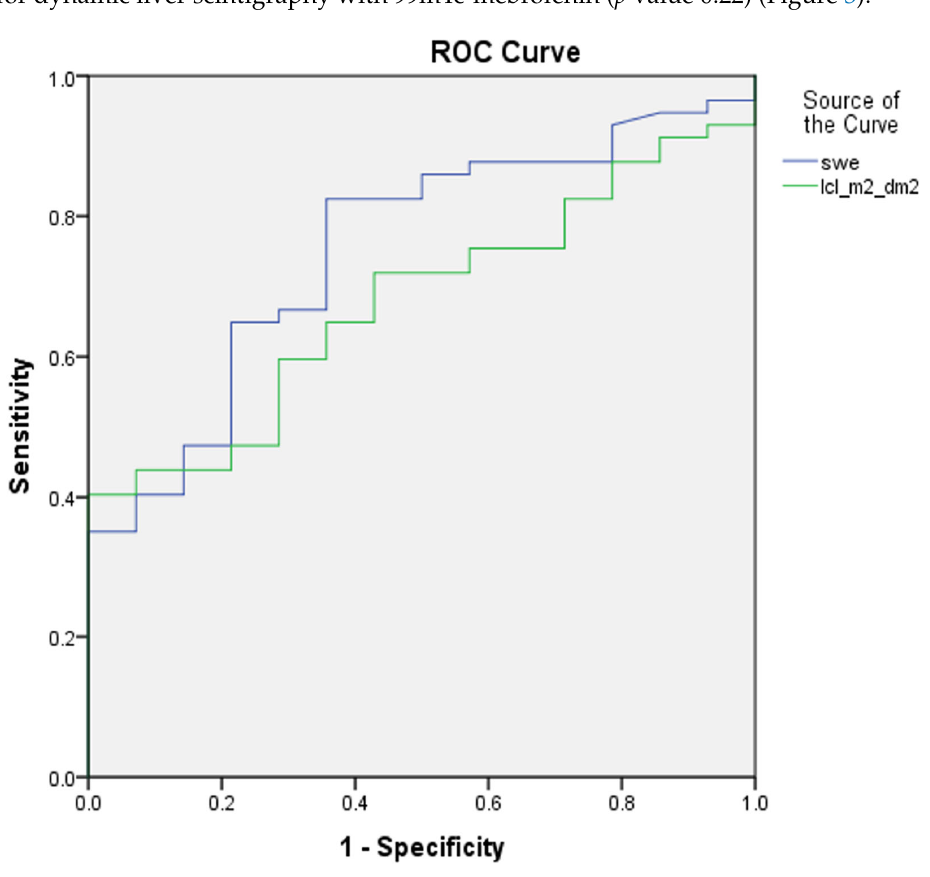
Figure 3. ROC curves of 2D ‐ SWE and dynamic liver scintigraphy, with 99mTc ‐ mebrofenin separat ‐ ing mild liver fibrosis; AUROC was 0.75 and 0.68, respectively ( p value 0.22). swe—2D ‐ SWE value represented in kPa; lcl_m 2 _dm 2 —liver clearance measured in right liver lobe and corrected using BSA and LA.